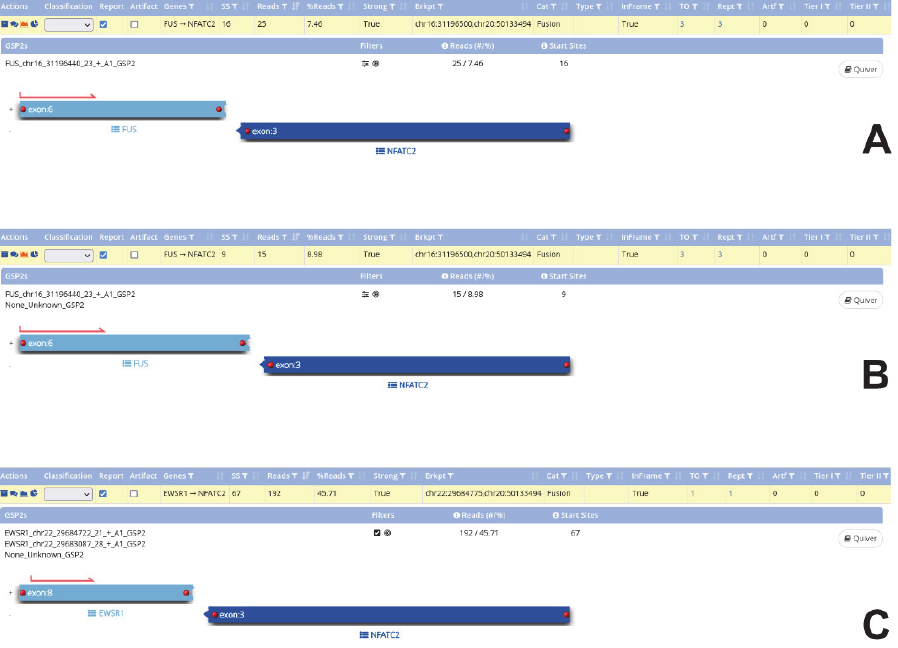
Figure 3. Schematic diagram of the fusion transcript for three cases. ( A , B ) In cases #1 and #2 FUS::NFATC2 fusion and ( C ) in case #4 EWSR1::NFATC2 fusion were documented. Images show the genes, exons, and locations of each fusion.